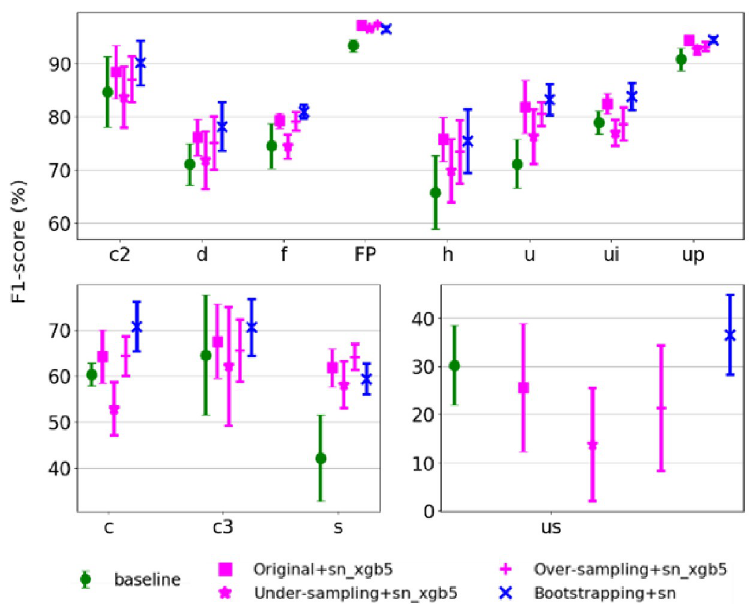
Fig 6. Performance of baseline model and the best model for each combination of resampling and ensemble methods. The performance of the baseline model (trained using a learning rate of 10 − 3 and without the use of resampling and ensemble methods) and the best model resulting from each ensemble method for different USV classes are shown. The mean ± STD of the class-wise macro F1-scores is based on the 8-fold